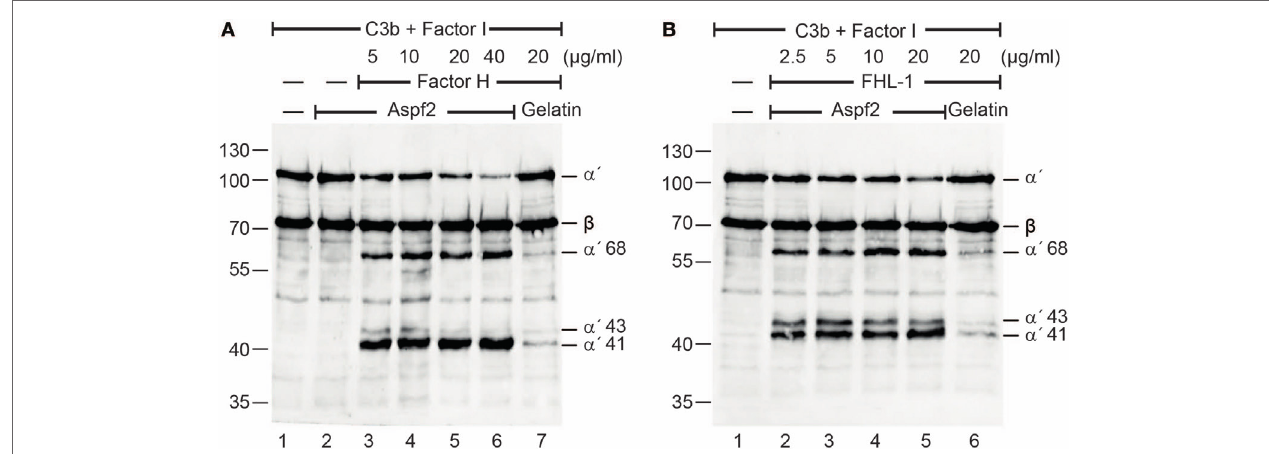
FigUre 2 | Factor H and factor-H-like protein 1 (FHL-1) bound to Aspf2 retrain cofactor activity. (a) Factor H was added at increasing amounts to immobilized Aspf2. After washing, C3b and factor I were added for 60 min; the reaction mixtures were subjected to SDS-PAGE, and C3b cleavage products were visualized by western blotting using goat human C3 antiserum. Factor H bound to Aspf2 assisted in Factor I-mediated cleavage of C3b, as indicated by the appearance of C3b cleavage products α′ 68, α′ 43, and α′ 41 bands (lanes 3–6). Aspf2 alone has no cofactor activity (lane 2). No C3b cleavage was detected in the presence of gelatin (lane 7). (B) FHL-1 at the indicated concentrations was added to Aspf2. Followed by C3b and Factor I addition and incubation, the proteins were separated by SDS-PAGE transferred to a membrane and C3 cleavage products were investigated by western blotting. FHL-1 showed cofactor activity and assisted in Factor I-mediated cleavage of C3b, as revealed by appearance of cleavage products α′ 68, α′ 43, and α′ 41 bands (lanes 2–5). These C3b cleavage products were absent in the negative control gelatin (lane 6). Panels (a,B) show representative results of three independent